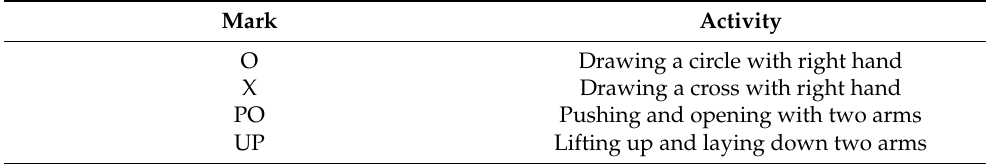
Figure 2. The layout of data collection locations. Table 1. Predefined